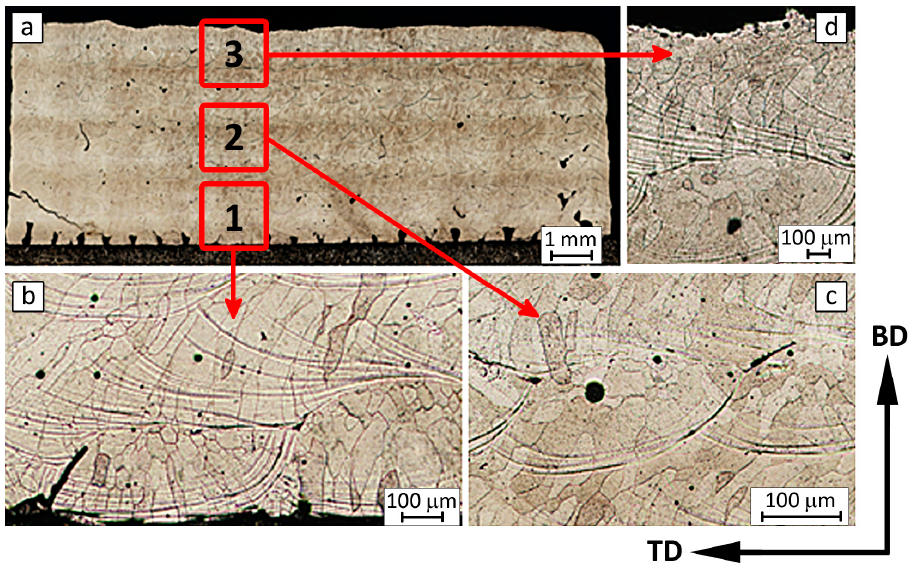
Figure 3. The macro ( a ) and microstructure of the Fe 3 Al alloy manufactured by LENS technique obtained at a high cooling rate at the substrate = bottom ( b ), half the height of the sample = middle, center ( c ), and top of the sample = surface ( d